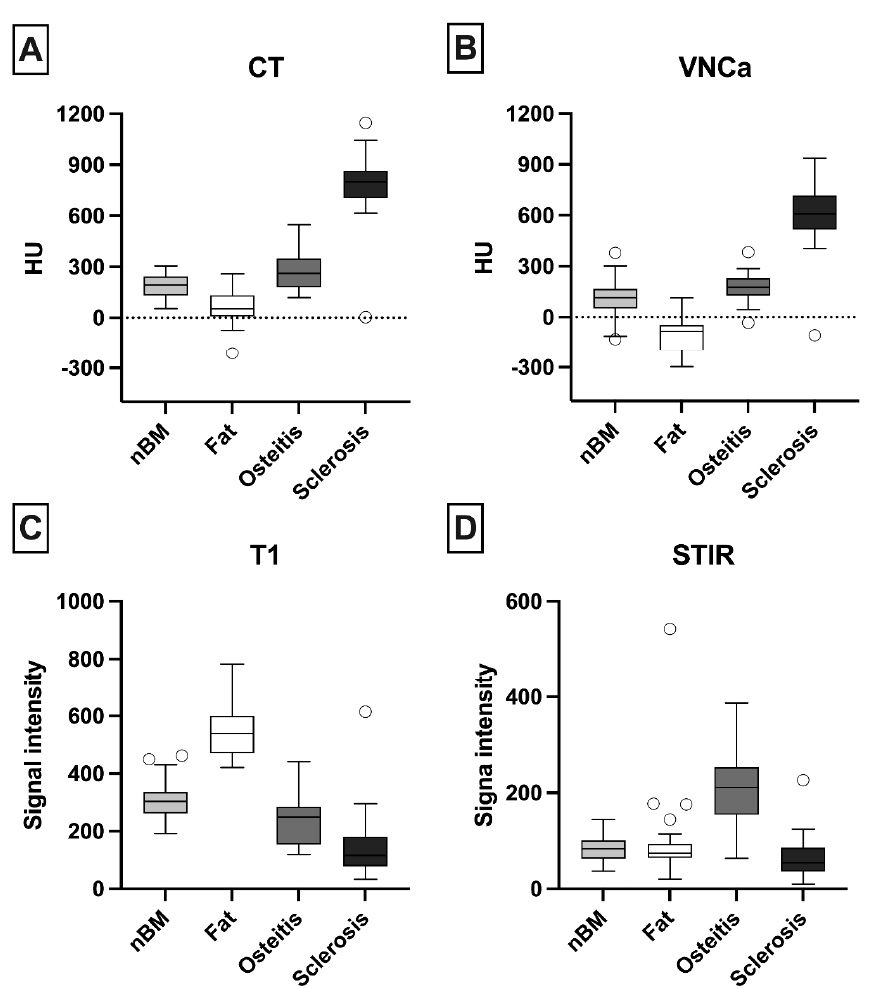
Figure 3. Results of quantitative analysis in ( A ) computed tomography (CT), ( B ): virtual non-Calcium Images (VNCa), ( C ) T1-weighted images and ( D ) short-tau inversion recovery (STIR). Region-of-interest (ROI) measurement was performed in univocal lesions based on subjective scoring. In standard CT, osteitis and fat could not be distinguished from normal bone marrow (nBM). Virtual non-calcium images (VNCa) allowed differentiation between fat metaplasia and normal bone marrow (mean difference: 233.1 HU, p < 0.01) but not between osteitis and normal bone marrow (mean difference: − 55.67 HU, p = 0.27). T1-weighted images showed high signal intensity for fat and were used as gold standard for identification of fat metaplasia, while short-tau inversion recovery (STIR) images showed high signal for osteitis and were used as gold standard for identification of osteitis. (mean difference: − 233.1 HU [ − 158.7– − 307.5 HU; p < 0.01). For osteitis, the mean